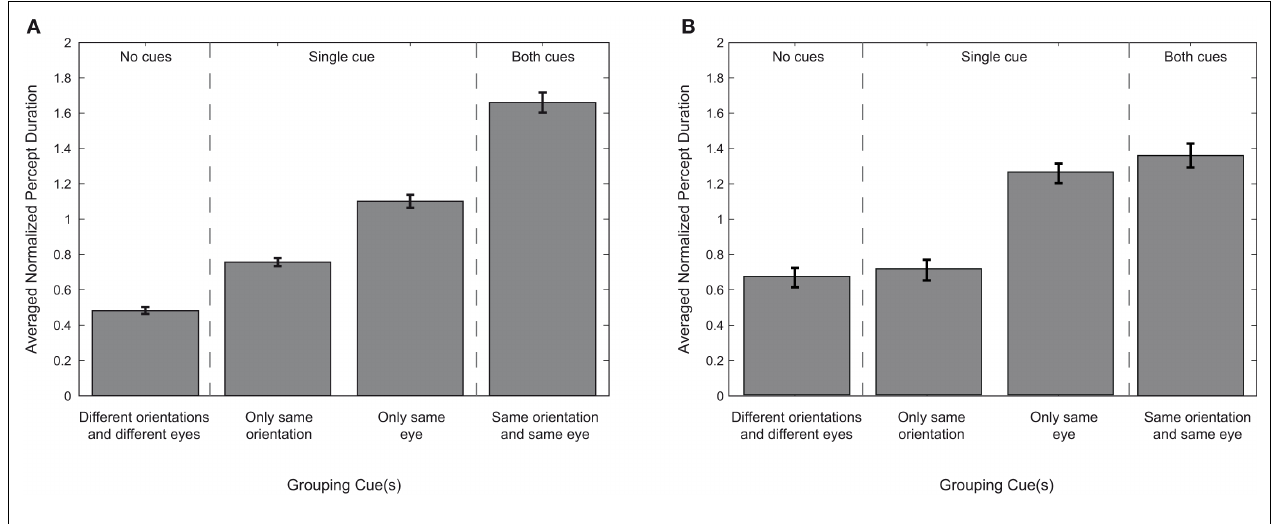
cues associated with each perceptual outcome.The results are plotted as a hierarchy to illustrate the relative potency of certain grouping cues over others. (A) Displays the results for our main experiment using cardinal orientations. (B) Displays the results for grouping when oblique orientations are